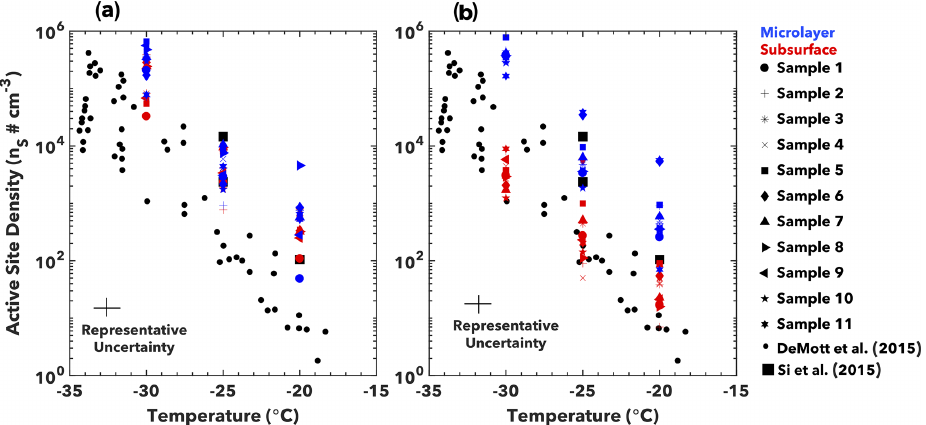
Figure 5. Immersion freezing. Active site density ( n s ) for immersion mode ice nucleation are shown for (a) ETNP and (b) Florida Straits seawater samples. Data points represent the average value n s at − 30, − 25, and − 20 ◦ C. Representative uncertainties in n s are derived from variability in replicate experiments, whereas temperature uncertainty arises due to variability in SPIN lamina conditions (Garimella et al.,